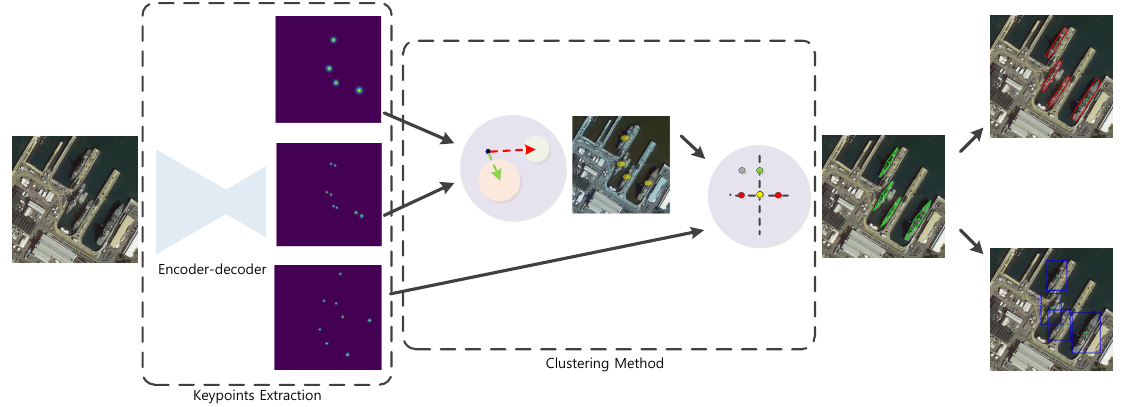
Figure 3. The complete flow of our method. The input image is first fed into an encoder-decoder network to extract keypoints. Then the keypoints are clustered into groups, where each group represent a single ship instance. Finally, both the regular rectangular bounding box and the rotated bounding box can be obtained by a simple transform